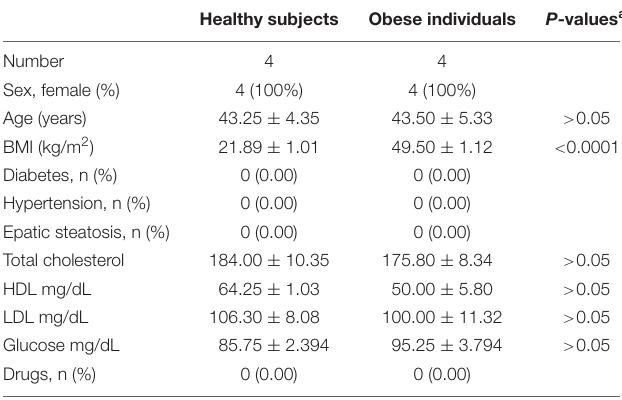
TABLE 1 | Demographic and clinical characteristics of healthy and obese